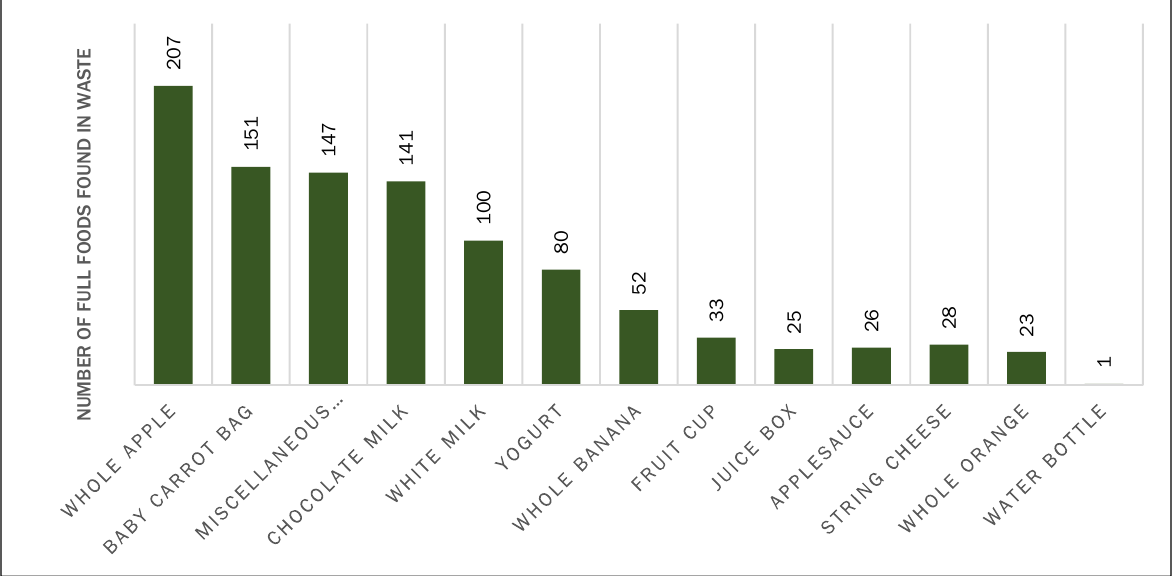
Breakdown of full food items found in trash, recycling, and compost bags during waste audits. All items set aside were under rescuable standards according to King County Green Schools Program guidelines. Miscellaneous packaged foods are described in Figure